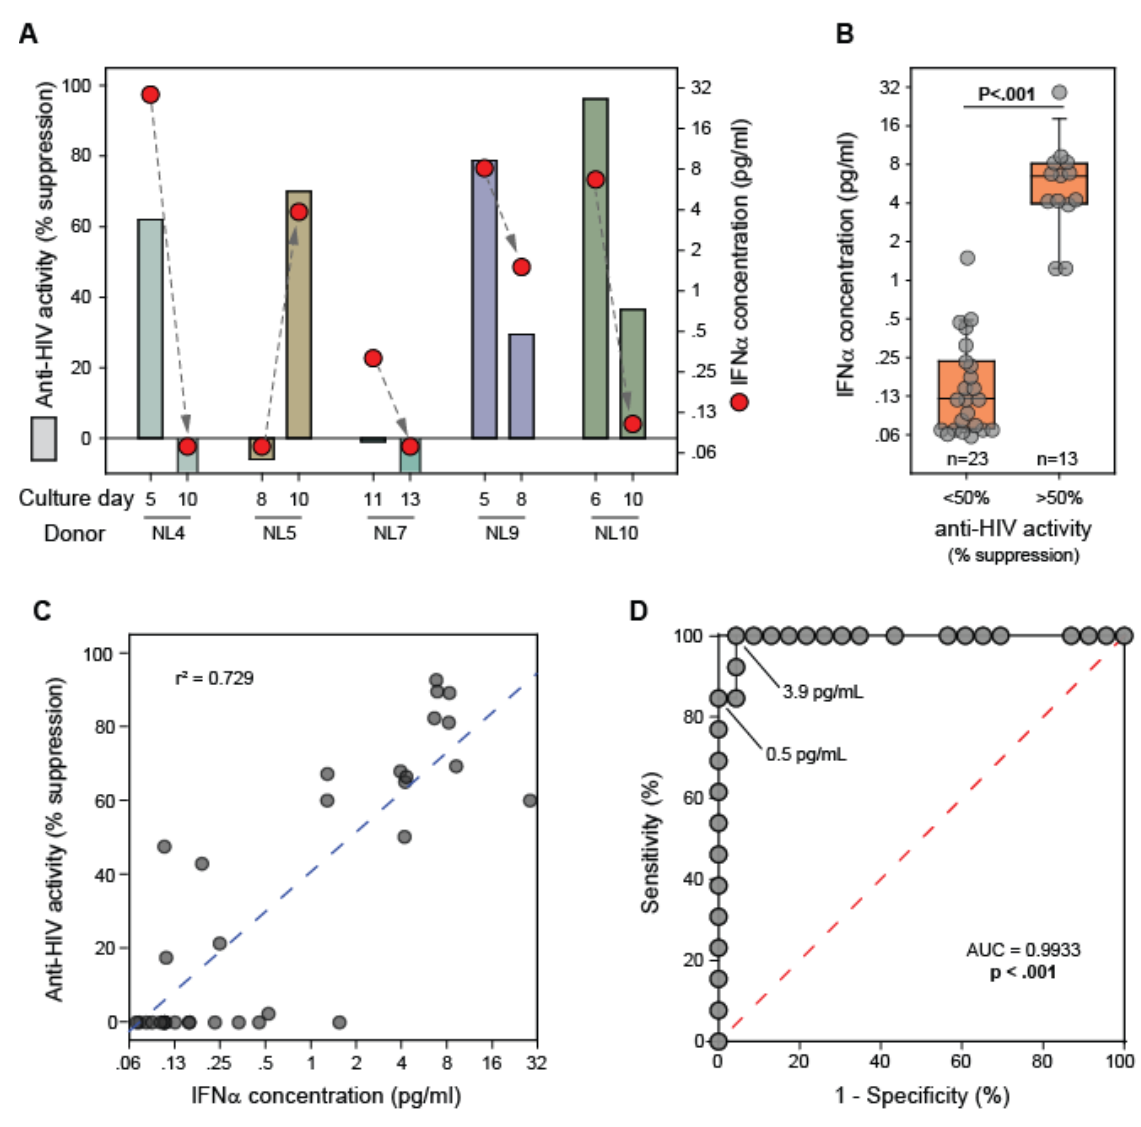
Figure 4. IFNa levels and anti-HIV-1 activities of CD8+ T cell culture supernatants . Supernatants were collected from CD8+ T cell cultures (n = 19 donors) at distinct time points and evaluated for anti- HIV-1 activity and IFNa concentration. ( A ) Longitudinal results are shown for the measured anti-